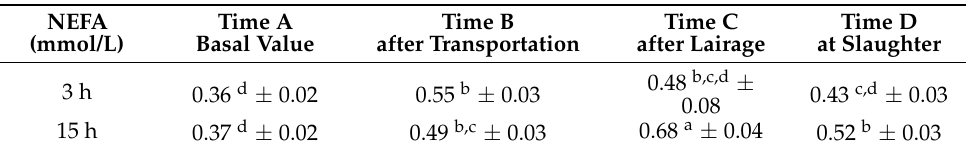
Table 2. NEFA values at different times within each slaughter group. Least-square means ± Stan- dard error. NEFA Time A Time B Time C Time D (mmol/L) Basal Value after Transportation after Lairage at Slaughter b,c,d ± 3 h 0.36 d ± 0.02 0.55 b ± 0.03 0.48 0.43 c,d ± 0.03 0.08 15 h 0.37 d ± 0.02 0.49 b,c ± 0.03 0.68 a ± 0.04 0.52 b ± 0.03 Values with different letters in the same line, differ p <